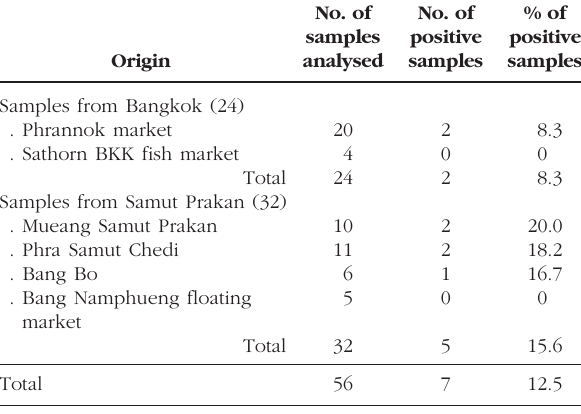
Table I. – Cryptosporidium contamination in mussels from Bangkok and Samut Prakan markets located on the bank of the Chao Praya